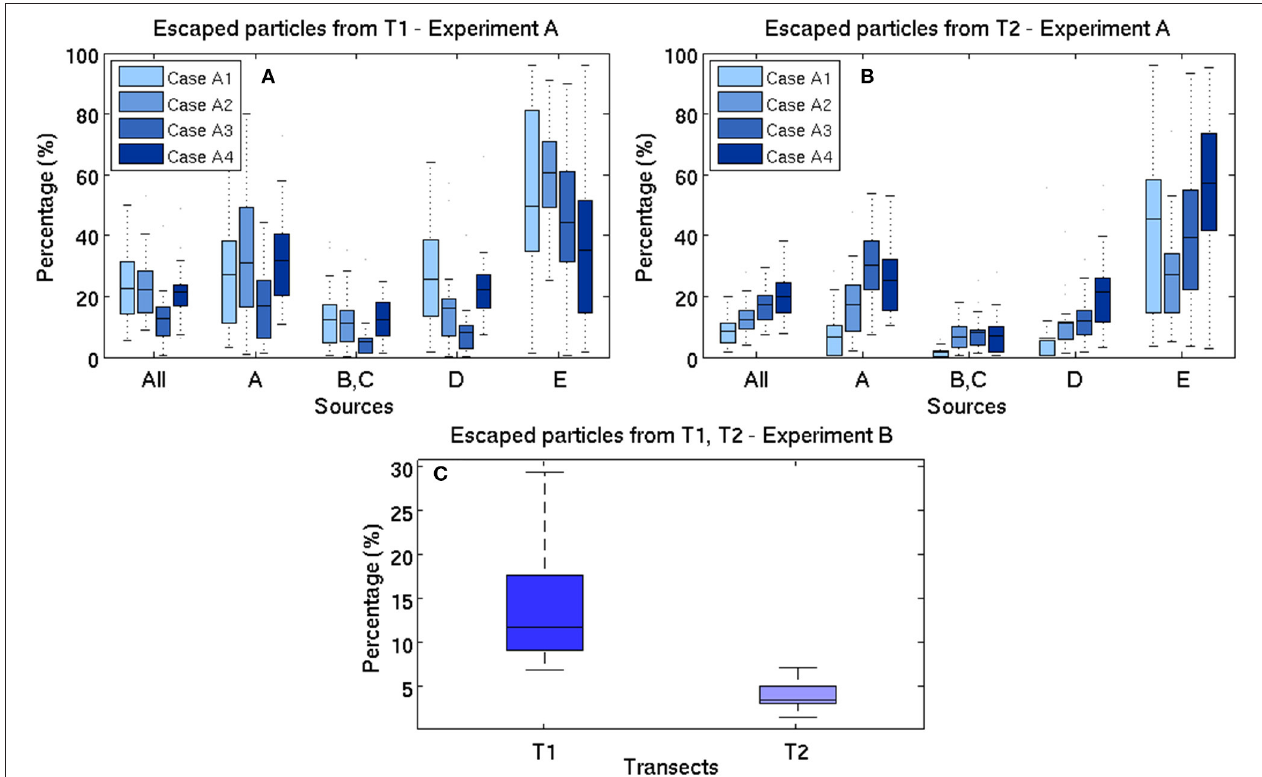
FIGURE 10 | Box plots depicting the percentages of escaped particles across: (A) transect T1 in Experiment A; (B) transect T2 in Experiment A, and (C) transects T1, T2 in Experiment B.